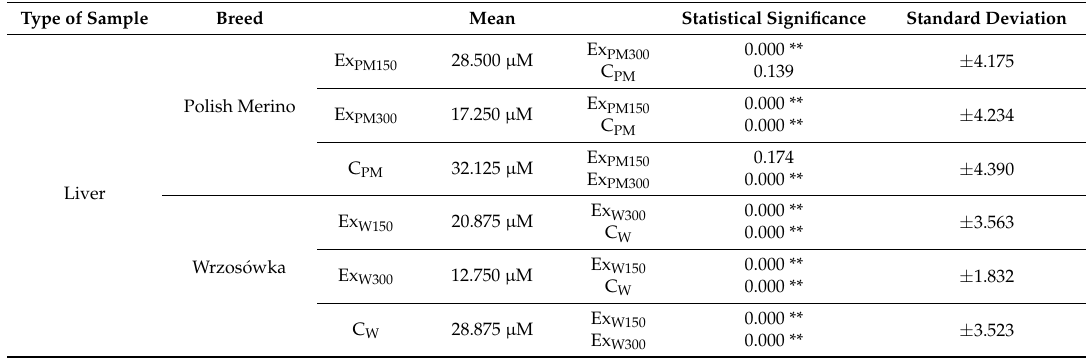
Table 6. The level of malondialdehyde ( µ M) in liver as affected by the dose of the additive.